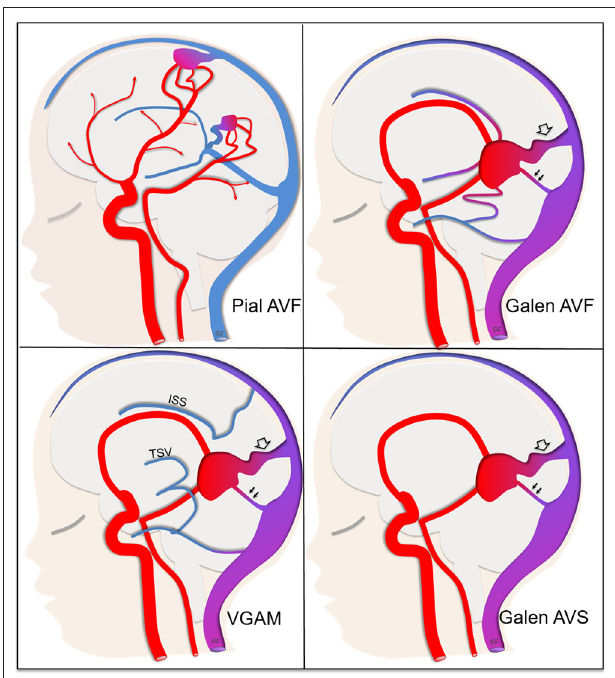
FIGURE 1 | Classification of arteriovenous shunts into four sub-types. Pial AVF (pial arteriovenous fistula) not draining directly into the vein of Galen. The deep venous drainage is anatomically normal. Galen AVF (Galen arteriovenous fistula) draining directly into the vein of Galen and either a pial or choroidal AVF. The deep venous drainage is anatomically normal, that means that the shunt can be responsible for venous reflux through the deep venous drainage (single arrows). VGAM (Genuine Vein of Galen aneurysmal malformation) draining directly into the vein of Galen. The deep venous system is disconnected from the vein of Galen itself with the deep cerebral veins [especially thalamostriate veins (TSV) and inferior sagittal sinus (ISS)] draining via alternative pathways either through the falcorial sinuses or lateropontic and lateromesencephalic veins to the superior petrosal sinus. That means that the shunt can’t be responsible for venous reflux through the deep venous system. Galen AVS (Galen arteriovenous-shunt) draining into the vein of Galen but with unknown anatomy of the deep cerebral veins. For shunts that drain directly into the vein of Galen, we noted the presence of a straight sinus (double arrow) and/or a falcine sinus (empty